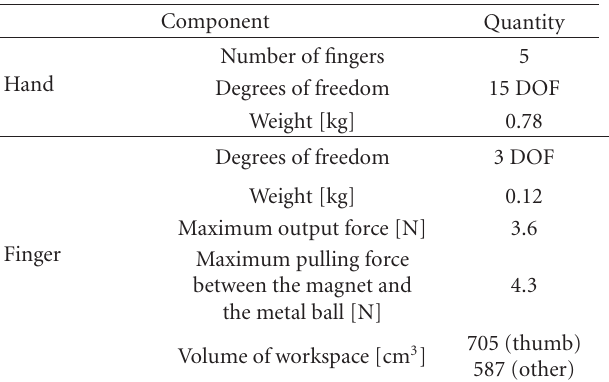
Figure 1: Outline of the system. The patient connects his/her fingertips to the multifingered haptic interface. Because this device is so small, it can be put on table and the patient can be seated during rehabilitation. Table 1: Specifications of the HIRO III